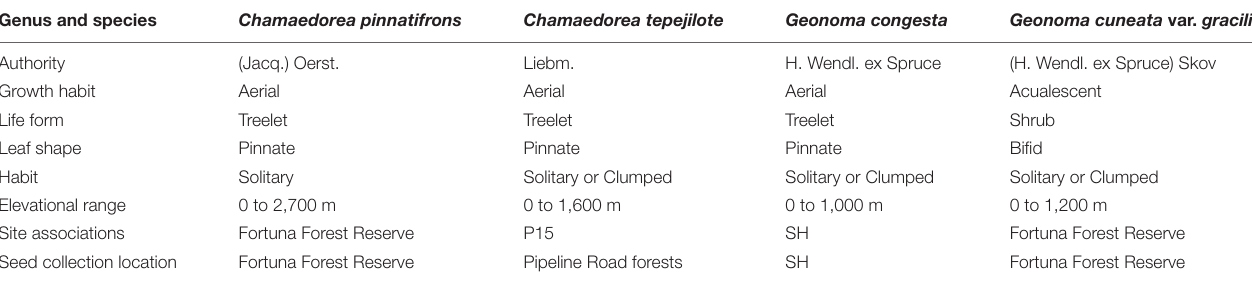
TABLE 2 | List of species and their general morphology and associated